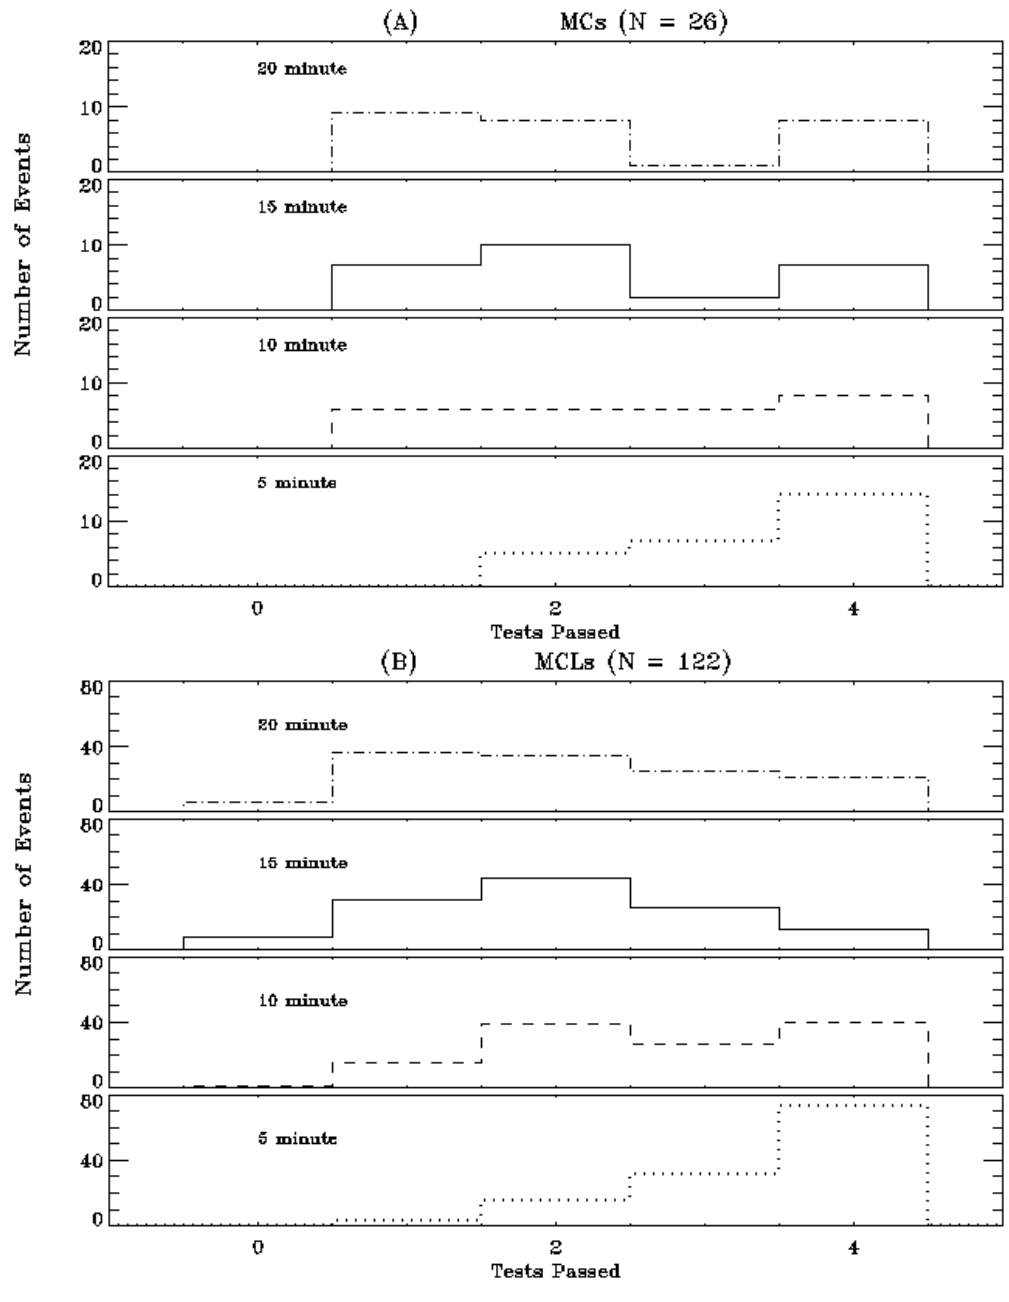
Fig. 2. (A) Histograms showing the number of WIND MC events that passed a given number of tests, up to a maximum of four tests, for the N =26 specially chosen MCs – see text (Data Set #1) with no regard to the specific nature of the test (i.e., test no.). From top to bottom, the dashed-dot histogram is for the 20min average study; the solid-line histogram is for the 15min average study; the dashed-line histogram is for the 10min study; and the dotted-line histogram is for the 5min study. (B) Similar to (A) except the histograms apply to the N=122 MCL event set (Data Set